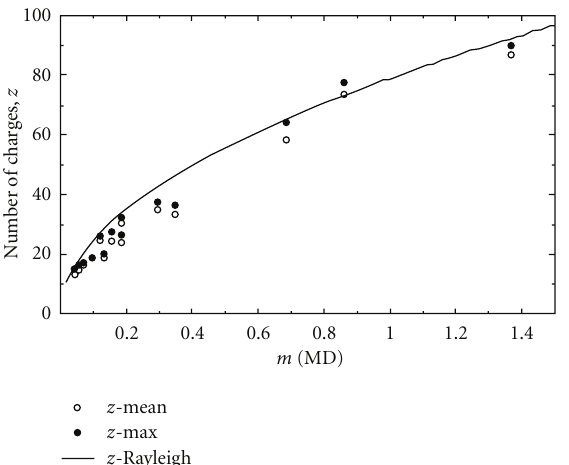
Figure 8: Plot of the average charge state ( z ) against molecular mass ( m ) for various proteins that follow CRM. [( • ) Observed highest charge state; ( ◦ ) observed lowest charge state; solid curve corresponds to the average charge state predicted by (4)]. The molecular weights of the proteins given on the x -axis are in units of 10 6 Da. (Reprinted with permission from Analytica Chimica Acta [61], Copyright 2000, Elsevier).